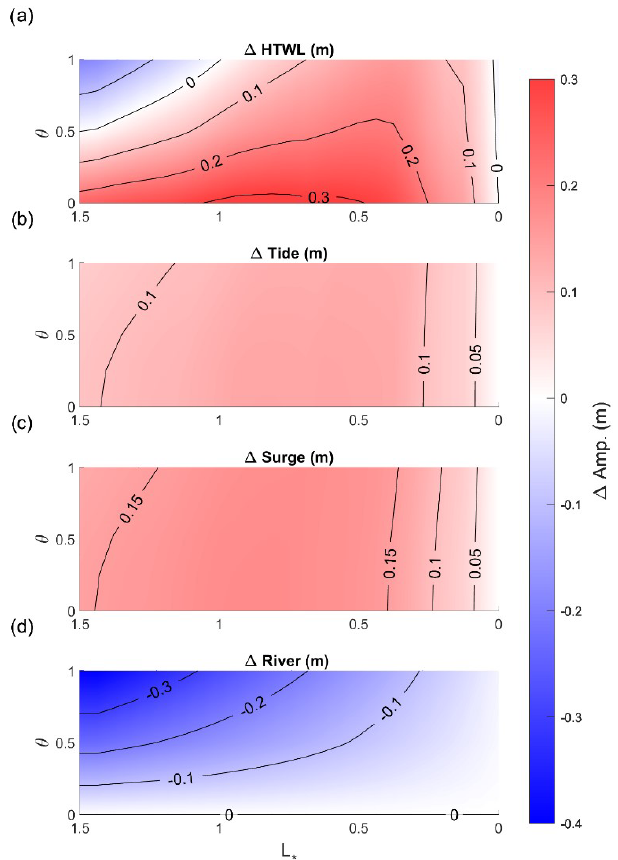
Figure 11. Comparison of the contribution of tide, surge, and river flow to compound flooding between 5 and 10m depth channel and Su Pri = 24h. (cid:49) represents the amplitude difference of each factor (HTWL, tide, surge, and river flow) between two controlling depths. The convergence length scale is 80km, the x axis represents the di- mensionless coordinate system of L ∗ = x/L e , and the y axis shows (cid:19) (cid:18) | u r | θ = . nondimensional river flow (cid:12) (cid:12) (cid:12) u D 2 (cid:12)